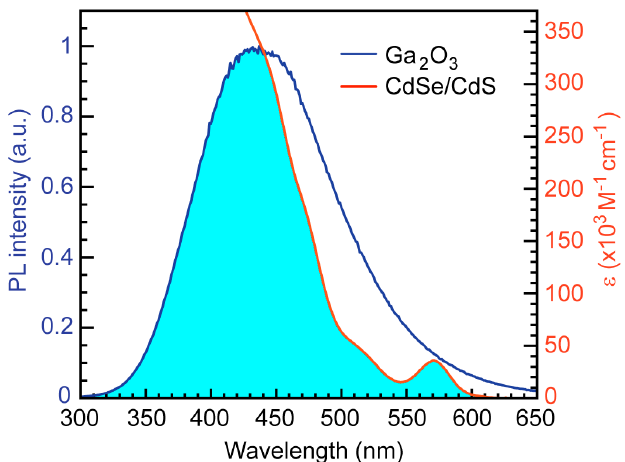
Figure 3. Absorption spectrum of CdSe/CdS NCs (orange line) and PL spectrum of Ga 2 O 3 NCs (blue line). Excitation wavelength for Ga 2 O 3 NCs is 250 nm. Shaded area indicates a spectral overlap, as an essential requirement for Förster resonance energy transfer (FRET).